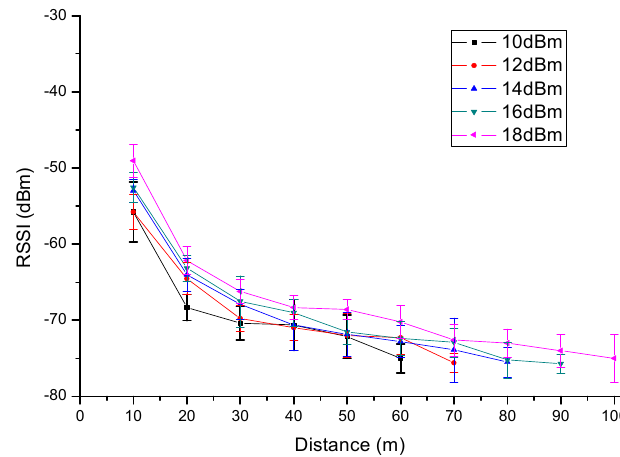
Figure 13. RSSI of 11 channels in the off-power state.